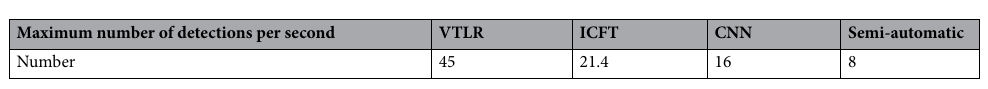
Table 6. Implementation results for the maximum number of detections per second.